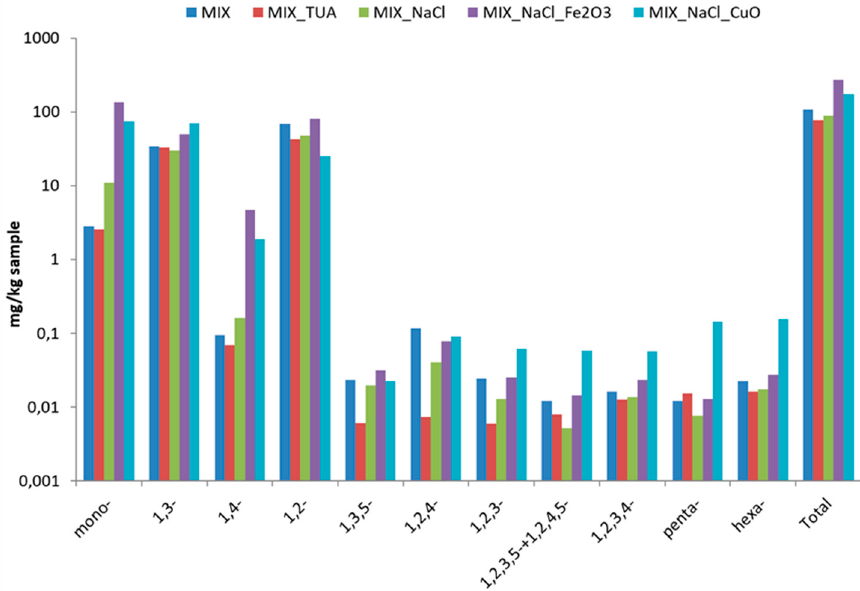
Figure 2. Emissions of chlorobenzenes (ClBzs) (logarithmic scale) during the combustion process at 850 °C (mg/kg sample).